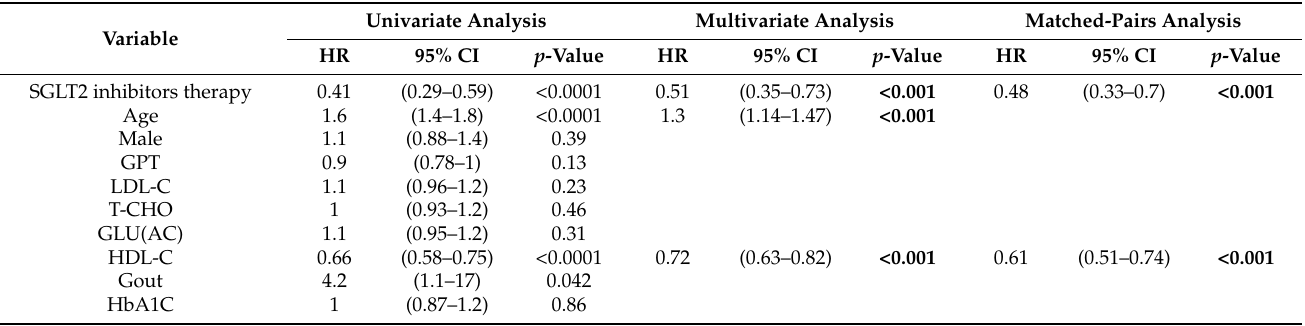
Table 4. Univariate and multivariate analyses for stroke incidence in the study patients.